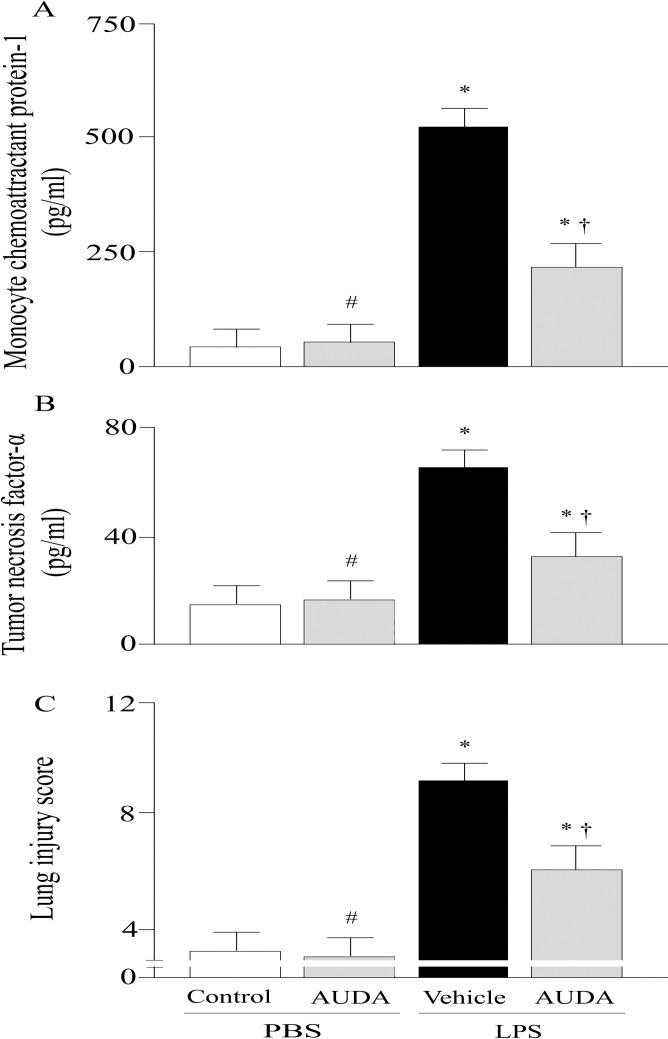
Alterations of monocyte chemoattractant protein (MCP)-1 levels (a), or tumor necrosis factor (TNF)-α levels (b), and histopathologic scoring (c) in control or lipopolysaccharide (LPS)-challenged animals treated with vehicle or AUDA. Data are expressed as the mean±SEM (n = 6~8) and compared by one-way analysis of variance and the Student-Newman-Keuls method or Kruskal-Wallis one-way analysis of variance on ranks and the Student-Newman-Keuls method. * P<0.05 when compared with control group; # P>0.05 when compared with control group; † P<0.05 when compared with vehicle group. PBS, phosphate buffered saline.